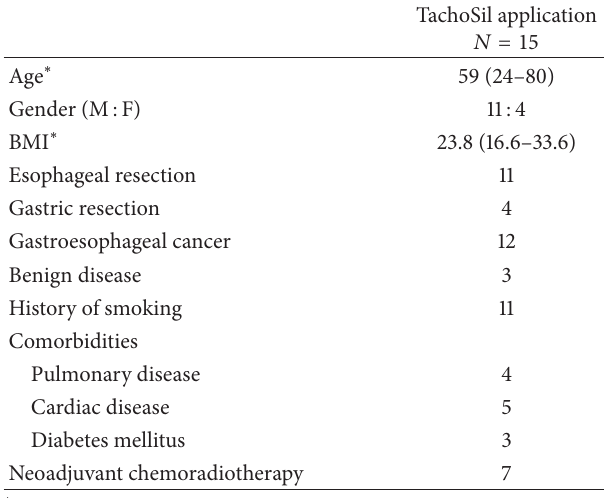
Table 1: Baseline characteristics of patients that received